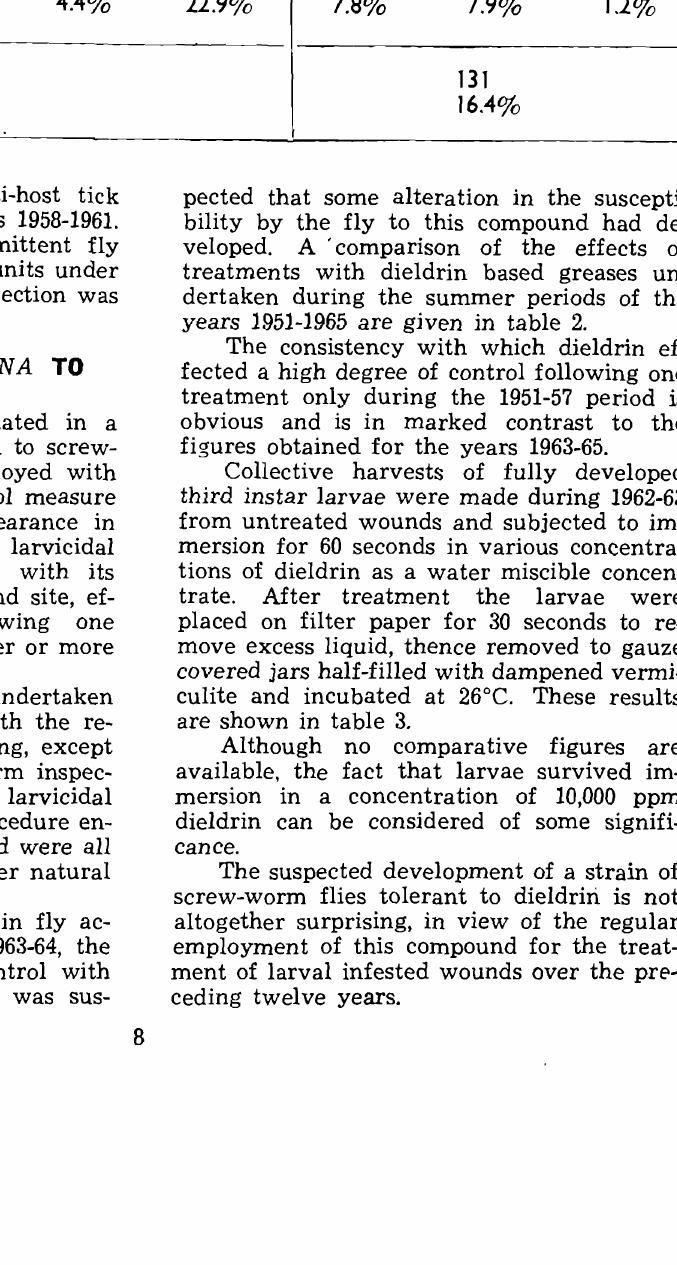
Table 1.-:-STRIKES RECORDED ON VARIOUS BOVINE BODY SITES SUMMARY OF ALL STRIKES 1951 -